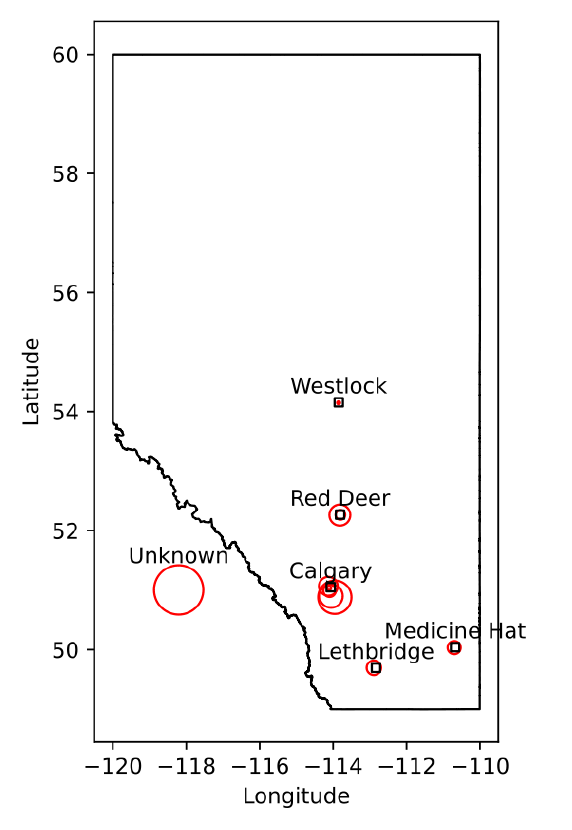
Figure 1. The distribution of clinics in Alberta, as well as their relative contribution of the dataset. Larger circles indicate larger contributions (in number of patients), with each circle representing one